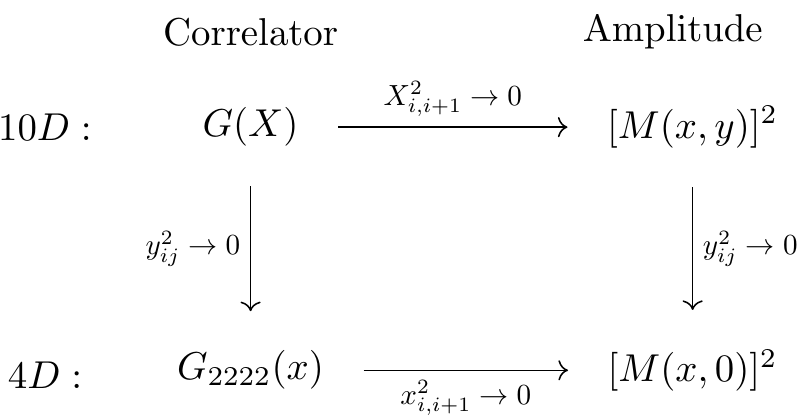
Figure 9 . Relationship between the massive (top) and massless (bottom) correlator-amplitude duality. All arrows commute at integrand level. The different massless limits are however not equivalent at the integrated